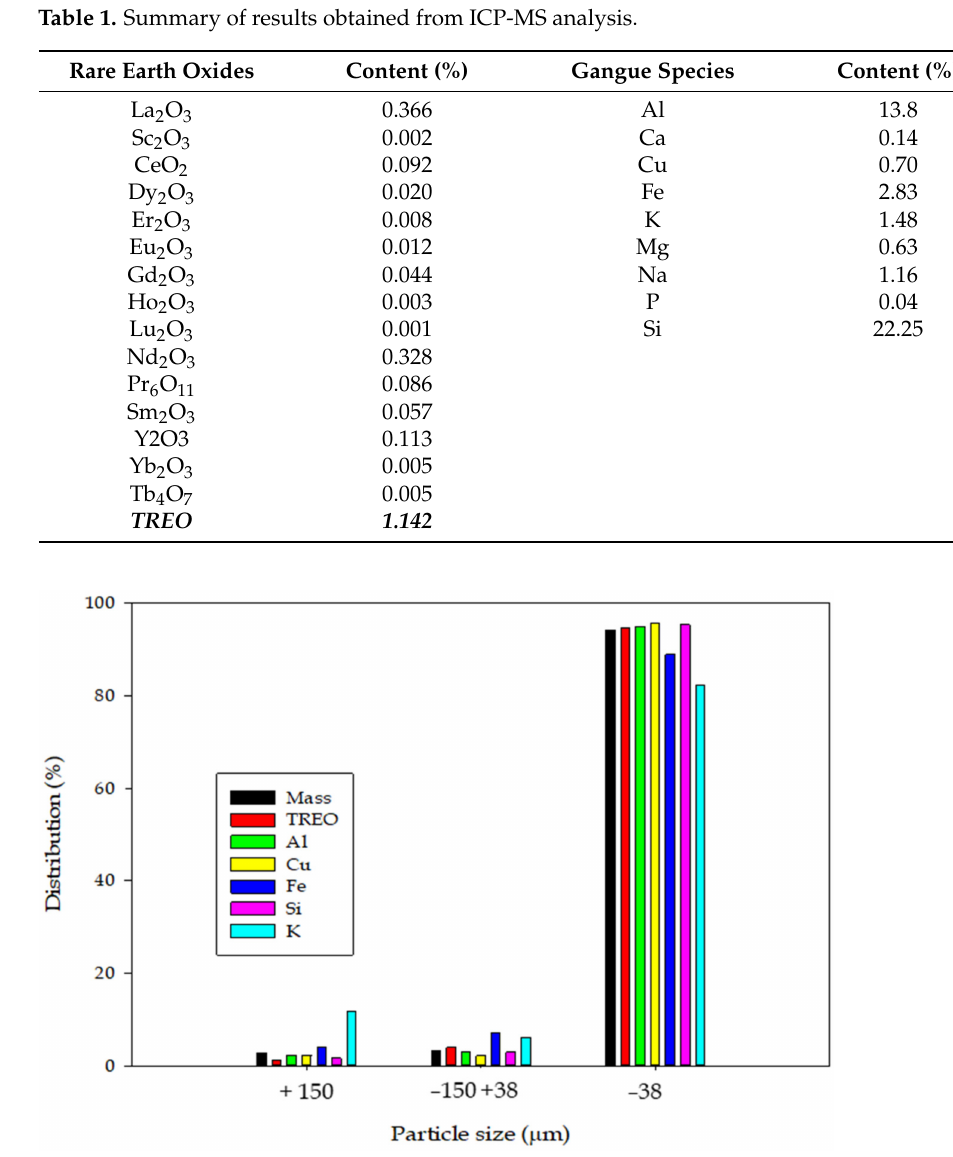
Figure 3. Mass, TREO, and selected major gangue elements distribution in the